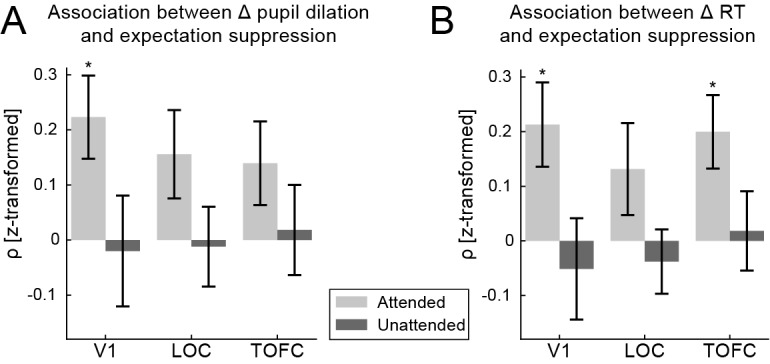
Expectation suppression is associated with pupil dilation differences and behavioral benefits of expectations.(A) Correlation of expectation suppression magnitude and pupil dilation differences due to expectation. When predictable objects are attended, trailing images that induce larger pupil dilation differences are also showing larger expectation suppression magnitudes in V1. No such association is evident when objects are unattended. (B) Correlation of expectation suppression magnitude and RT benefits due to expectation. When predictable objects are attended, larger RT benefits are associated with larger expectation suppression effects in V1 and TOFC. This association is absent when objects are unattended. Error bars indicate within-subject SEM. *p<0.05.10.7554/eLife.47869.012Figure 4—source data 1.Neural effects of expectations are associated with pupil dilation differences and reaction time benefits.The source data file contains two JASP files of the analyses conducted on the correlation coefficients (Fisher z-transformed Rho), correlating expectation suppression (neural metric) with (A) pupil dilation differences due to expectations and (B) RT benefits due to expectations (behavioral measure). Correlation coefficients for data from the three ROIs (V1, LOC, TOFC) and both attention tasks are provided.